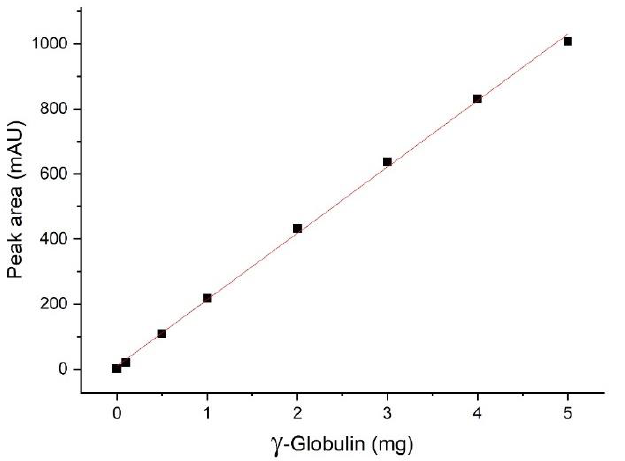
Figure 14. Calibration line for the quantification of IgG. Different concentrations of bovine IgG were injected directly into the system without a column.